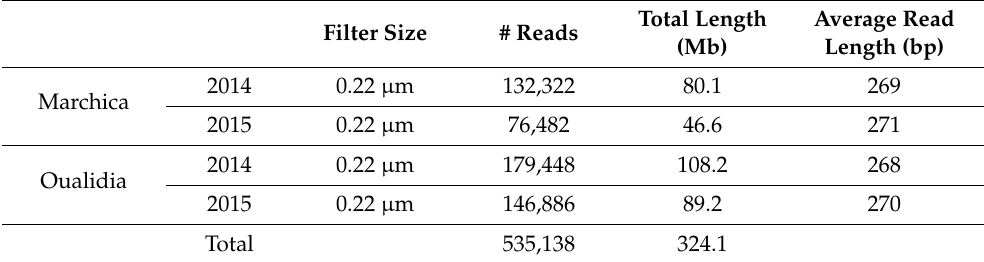
Table 2. Number of raw DNA sequence reads (R1 Forward and R2 Reverse) obtained from each Sterivex filter for both amplicon from Marchica and Oualidia water lagoons.